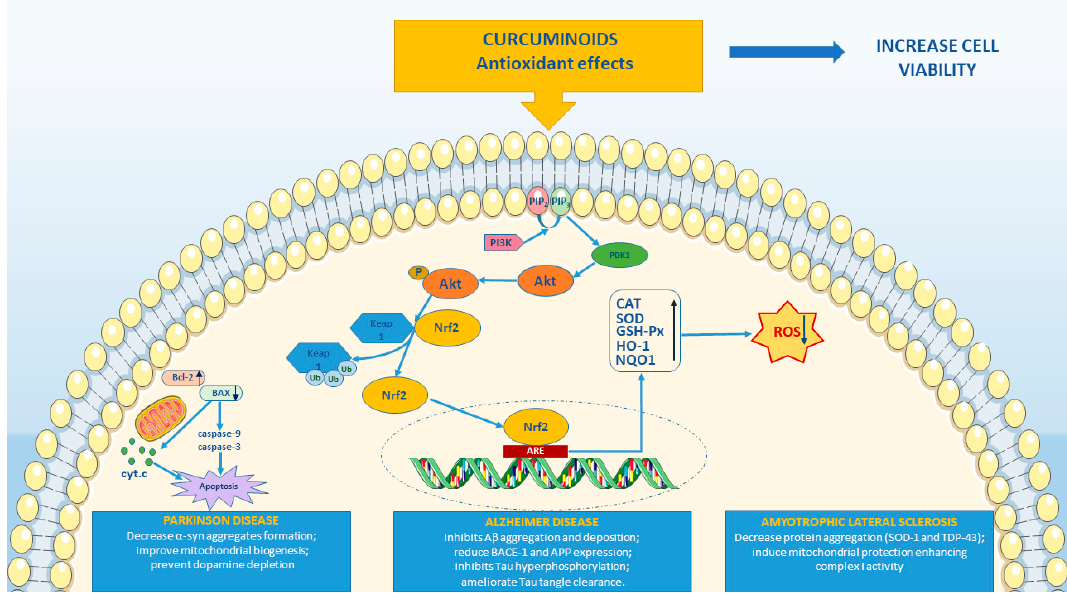
Figure 3. Graphical representation illustrates the principal antioxidant effects of curcuminoids in Parkinson’s disease (PD), Alzheimer’s disease (AD) and amyotrophic lateral sclerosis (ALS). The figure was made taking the images from Servier Medical Art (available at http://smart.servier.com/ accessed on 12 February 2021), licensed under a Creative Commons Attribution 3.0 Unported License (https://creativecommons.org/licenses/by/3.0/ accessed on 12 February 2021). PIP 2 , Phosphatidylinositol 4,5-bisphosphate; PIP 3 , Phosphatidylinositol (3,4,5)-trisphosphate; PDK1, Phosphoinositide- dependent kinase-1; PI3K, Phosphoinositide 3-kinase; Akt, Protein kinase B; Keap1, Kelch-like ECH-associated protein 1; Ub, Ubiquitin; P, phosphate; Nrf2, Nuclear factor erythroid 2-related factor 2; ARE Antioxidant response element; CAT, catalase; SOD, superoxide dismutase; GSH-Px, glutathione peroxidase; HO-1, heme oxygenase-1; NQO1, NAD(P)H quinone oxidoreductase 1; ROS, Reactive oxygen species; Bcl-2, B-cell lymphoma 2; BAX, bcl-2-like protein 4; cyt. c, cytochrome complex; α -syn, alpha-synuclein; A β amyloid- β ; BACE1, beta-amyloid converting enzyme 1; Tau, Tau protein; APP, Amyloid precursor protein; SOD1, superoxide dismutase 1; TDP43, TAR DNA-binding protein